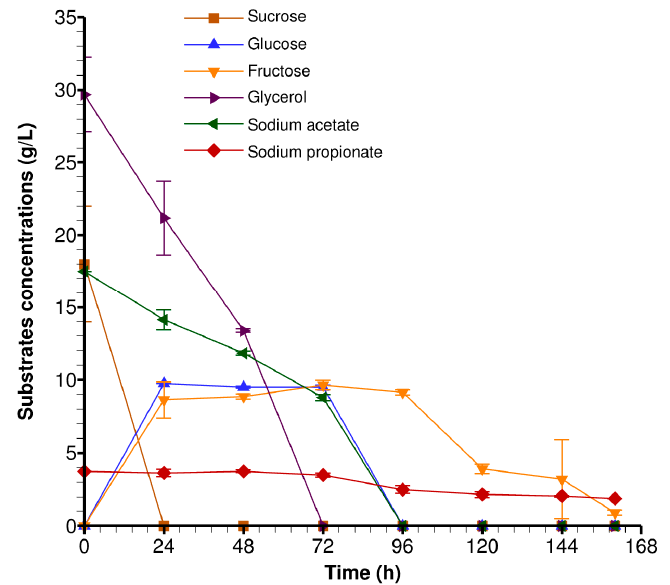
Figure 4. Substrates consumption during the batch fermentations conducted in 5-L bioreactors using a sucrose concentration of 20 g/L in sugar beet molasses.